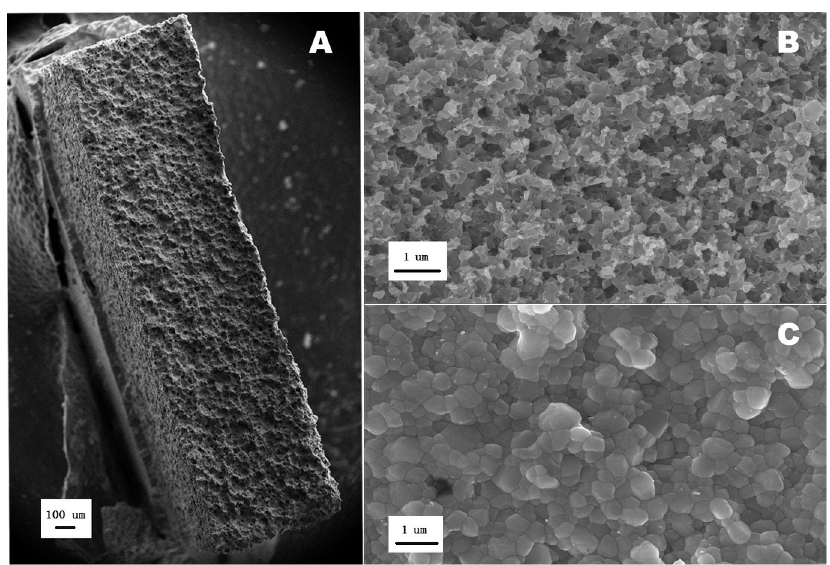
shallow concavities can be observed. In contrast, no etched morphology can be observed in C.